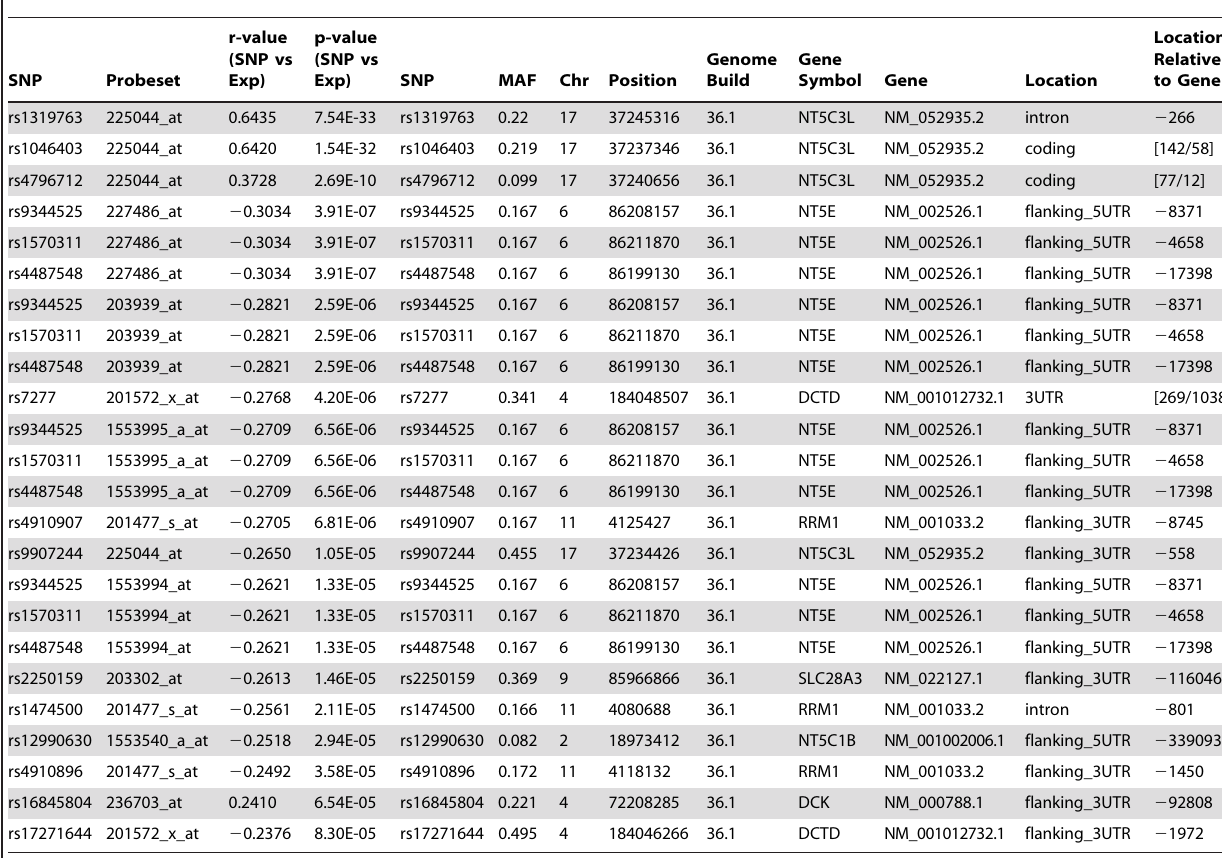
Table 5. 24 candidate SNPs with cis-regulation of pathway genes (p , 0.0001).